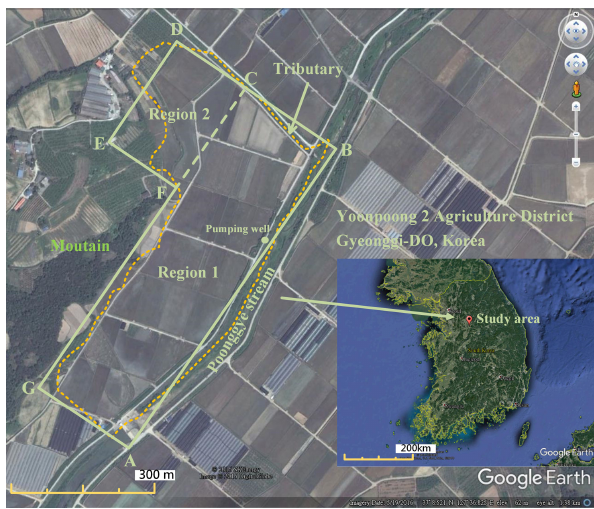
Figure 1. Location of the fluvial aquifer. Note that this figure is modified from Google